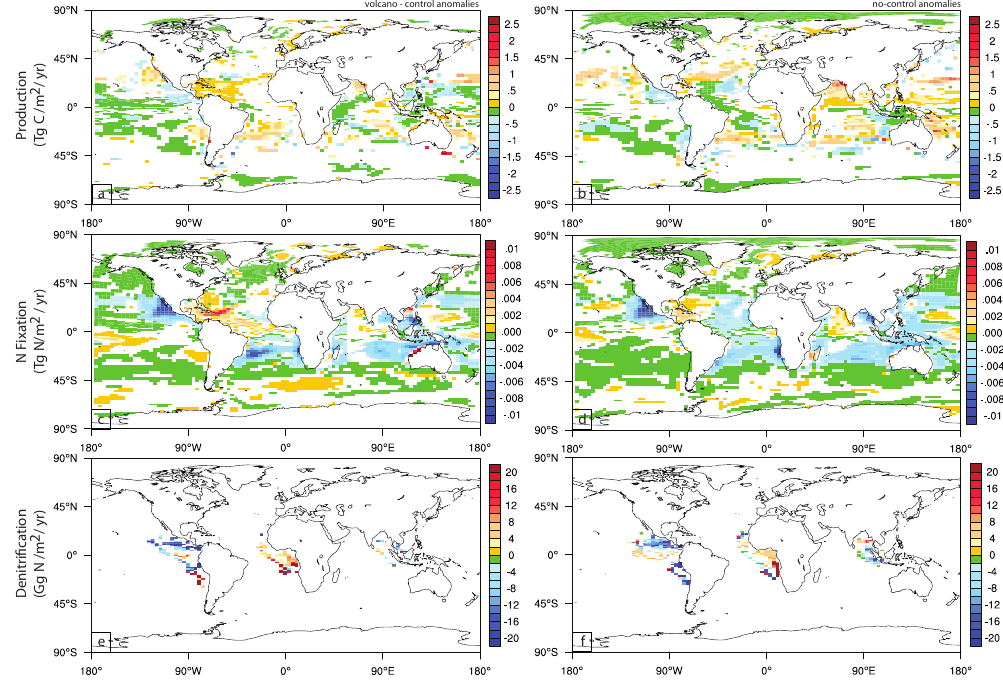
Fig. 10. Gridded ocean anomalies, averaged over the subset of 5 eruptions in Table 1 for the two-year period immediately following the eruptions. Only anomalies significant at the 90% level are drawn. Globally, the modeled ocean response is weak, but there are small regions of substantially stronger responses, such as the large zones of decreased or increased nitrogen fixation on either side of Central